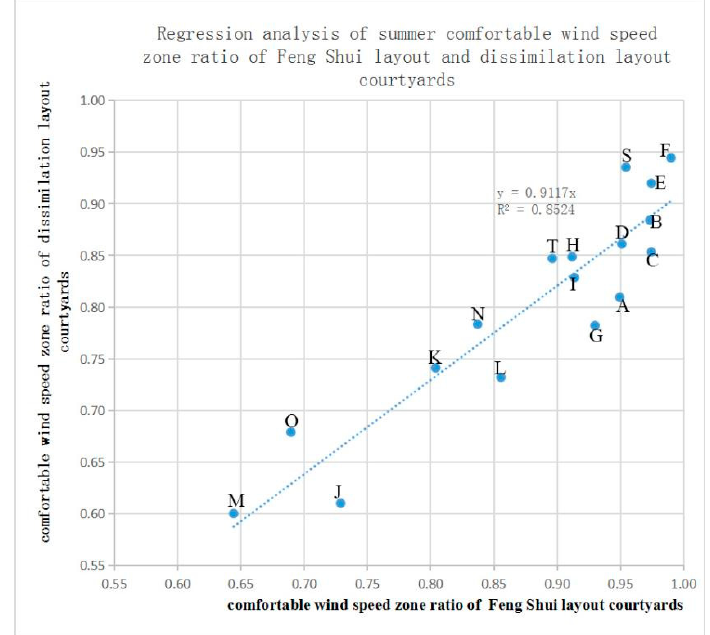
Figure 11. The regression analysis of the comfortable wind speed zone ratio for the courtyards of feng shui layout and dissimilation layout in summer. The values of the figure was based on CFD simulation results.